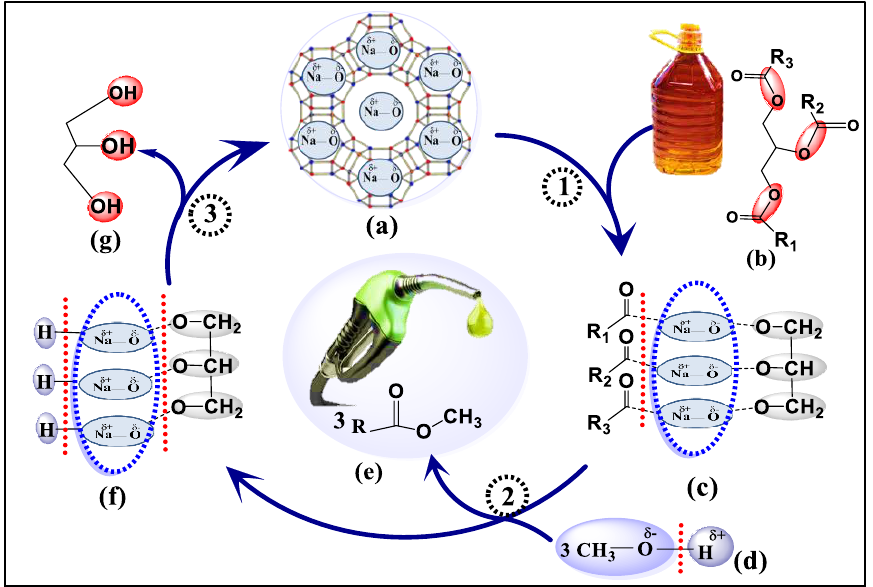
Figure 6. Schematic diagram for the transesterification mechanism of waste cooking oil over the synthetic zeolite-A particles. synthetic zeolite-A